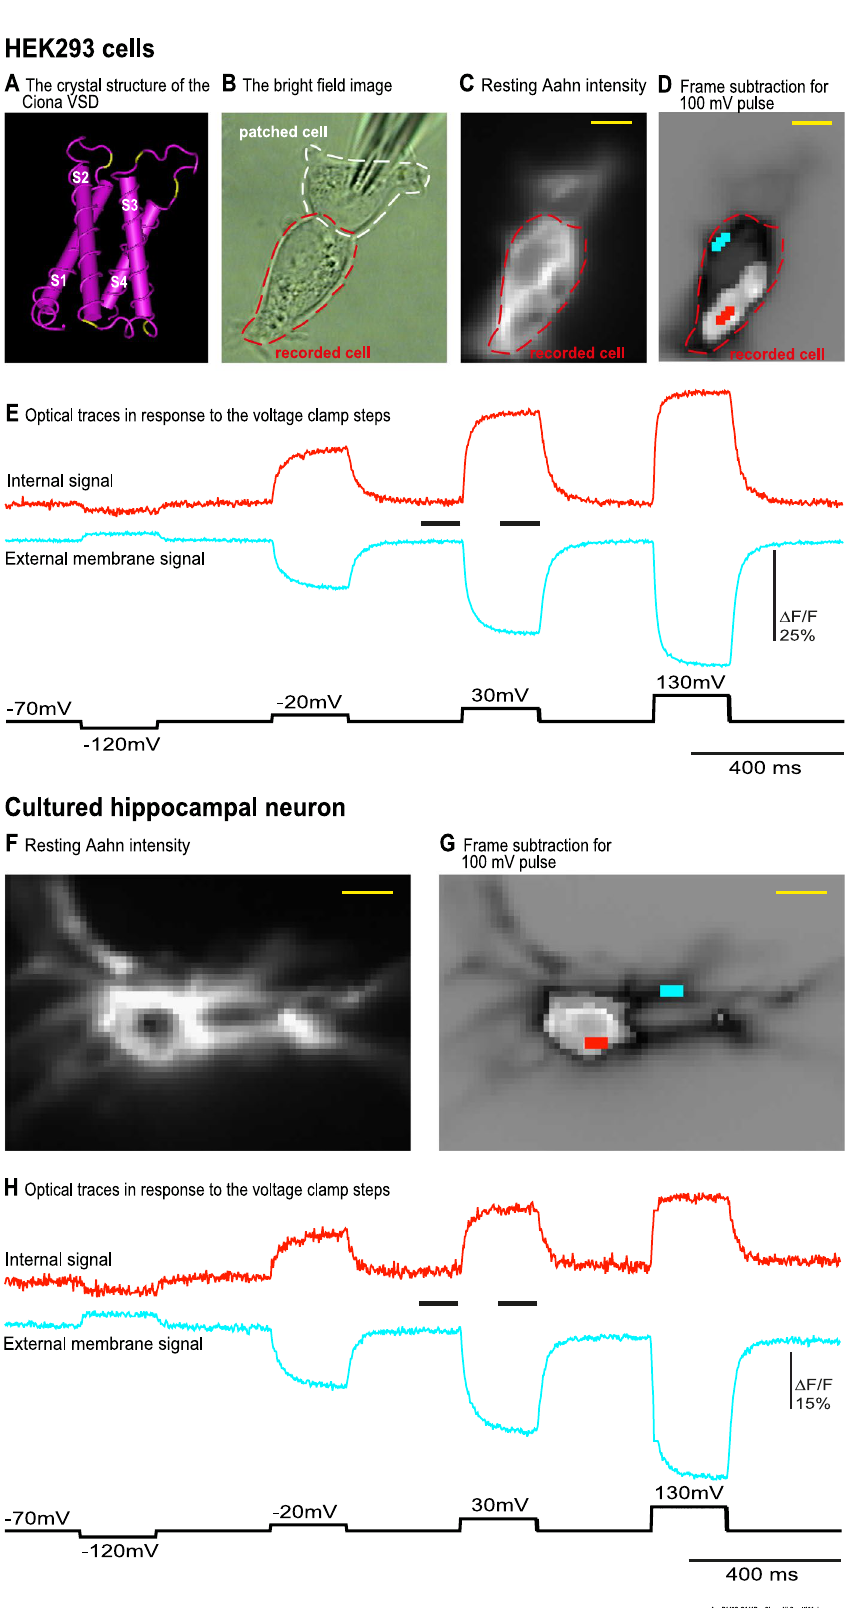
Figure 1. The internal membrane has an electrical interaction with plasma membrane in HEK293 cells and hippocampal neurons. HEK 293 cells and neurons expressing Aahn were voltage-clamped. Unless otherwise indicated, the holding potential was − 70 mV. In this and subsequent figures the pulse protocol is shown in the black trace. ( A ) The crystal structure of the Ciona voltage-sensing domain. The yellow residues